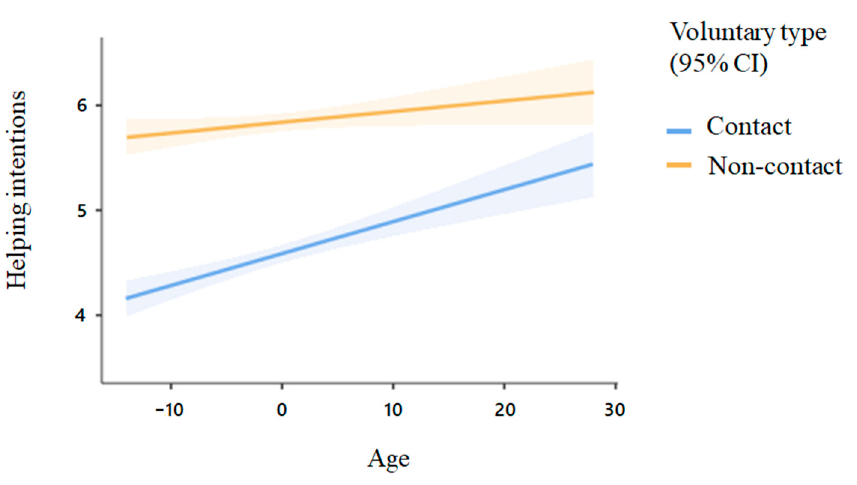
Figure 2. The effect of gender on helping intentions toward different types of voluntary work. Note. Error bars represent 95% confidence intervals.